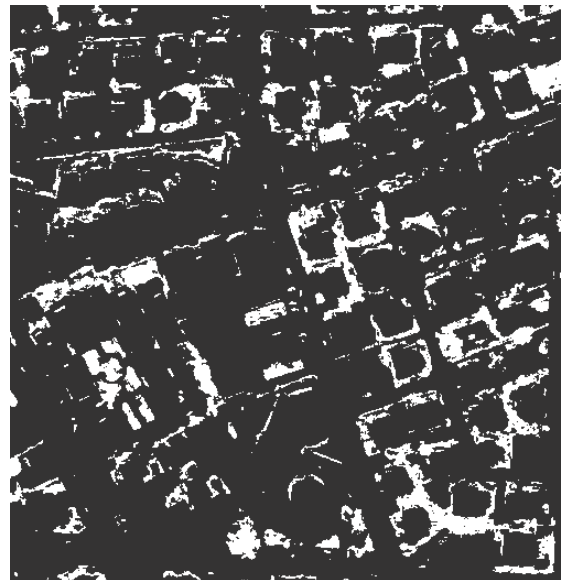
Figure 1. Vegetation and shadow areas mask derived from supervised classification of orthorectified multispectral image